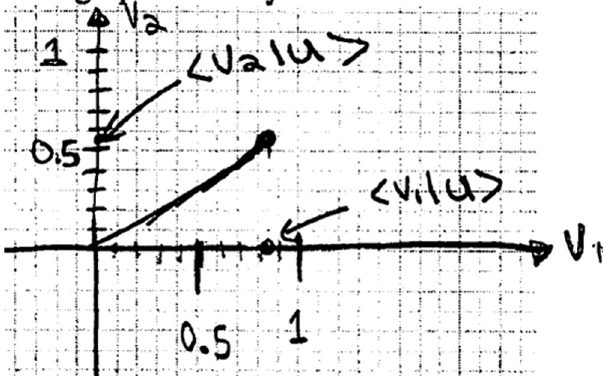
FIG. 10. Student ’ s graph of the vector in the new basis. Inclusion of the grid allowed students to create their own scale and graph the vectors more accurately.